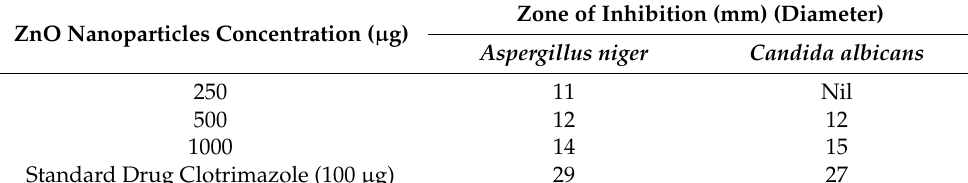
Table 4. Antifungal activity of ZnO nanoparticles.